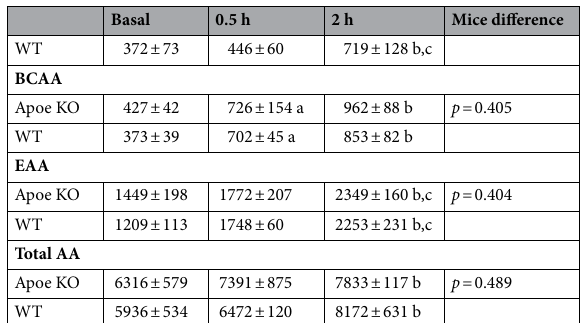
Table 1. Muscle free AA concentrations in μM at basal and at 0.5 and 2 h post whey feeding in Apoe KO and WT mice (n = 4 at each time point of each mouse). (a) denotes difference between basal and 0.5 h ( p < 0.05), b) denotes difference between basal and 2 h ( p < 0.05), (c) denotes difference between 0.5 and 2 h ( p < 0.05). Data shown as mean ±